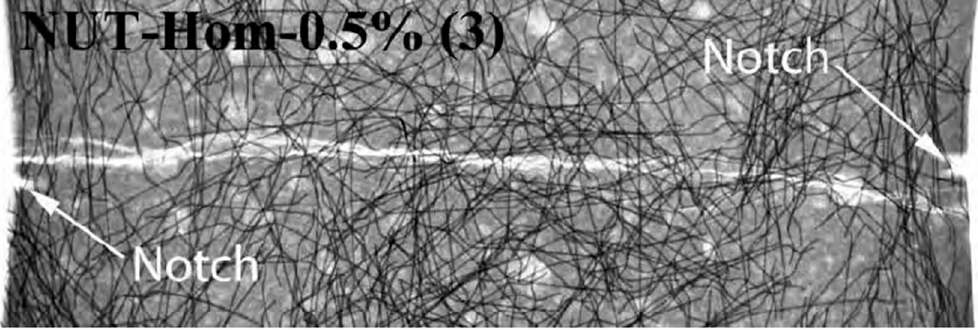
Figure 8. X-ray imaging of steel fibre reinforced OPC at 0.5% volume fraction of dog bone specimens showing the crack path was influenced by fibre dispersion with crack propagating through the section of concrete with the least resistance [41].